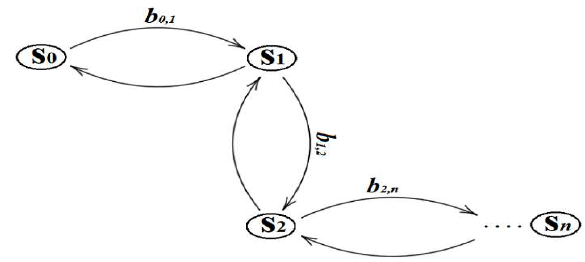
Figure 6. RR-MAC Markov